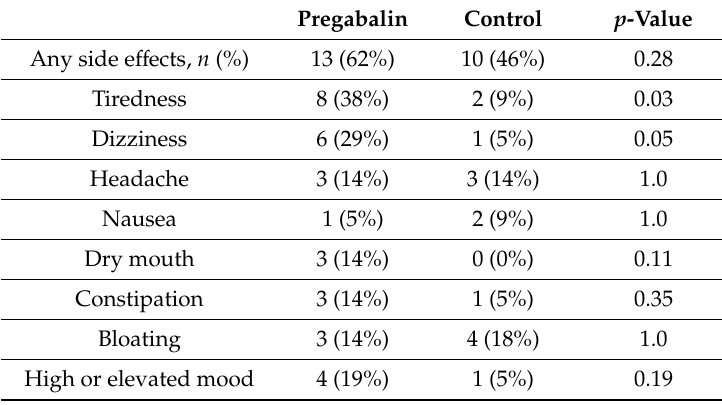
Table 6. Side e ff ects reported, by treatment